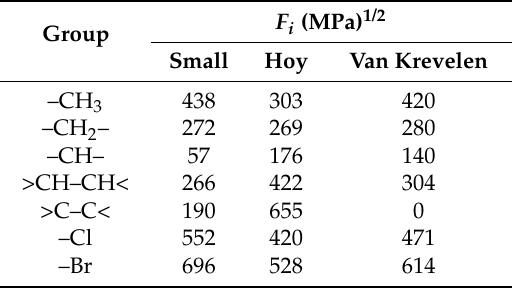
Table 2. Molar attraction constants, F i , at 25 ◦ C for repeating units from EPDM, EPDM/IIR,